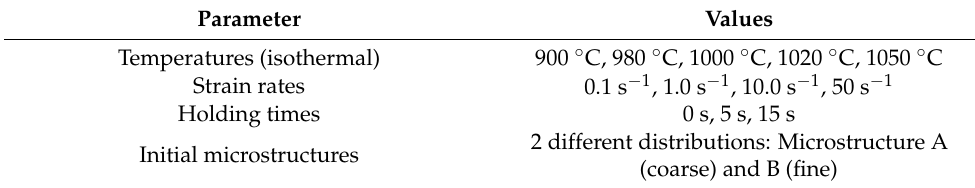
Table 2. Testing parameters for double cone compression tests.